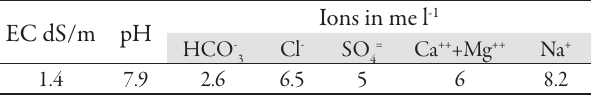
Tab. 2. Chemical analysis of the irrigated water